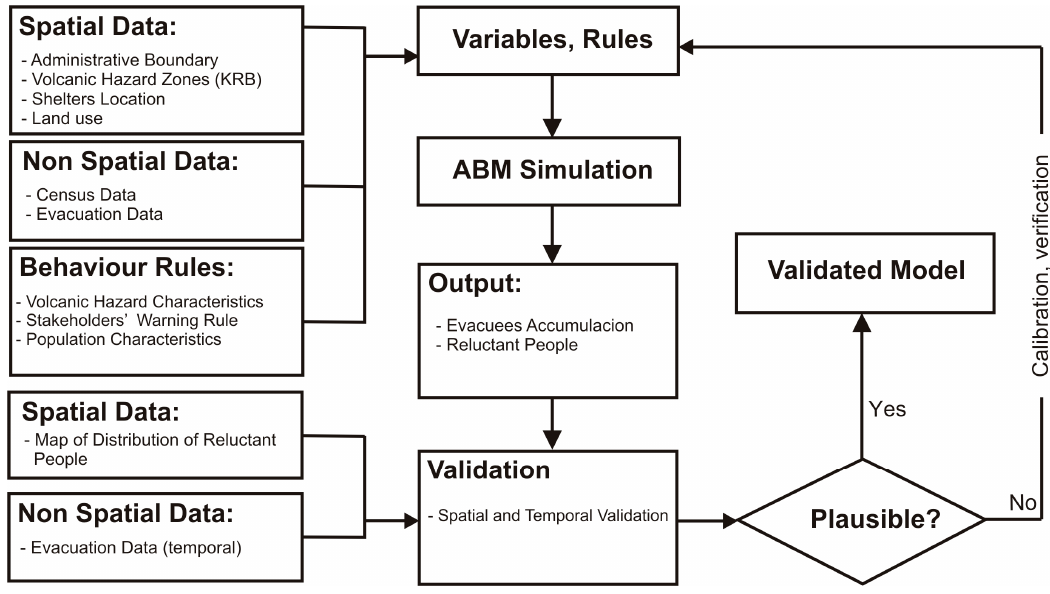
Figure 2. General framework.